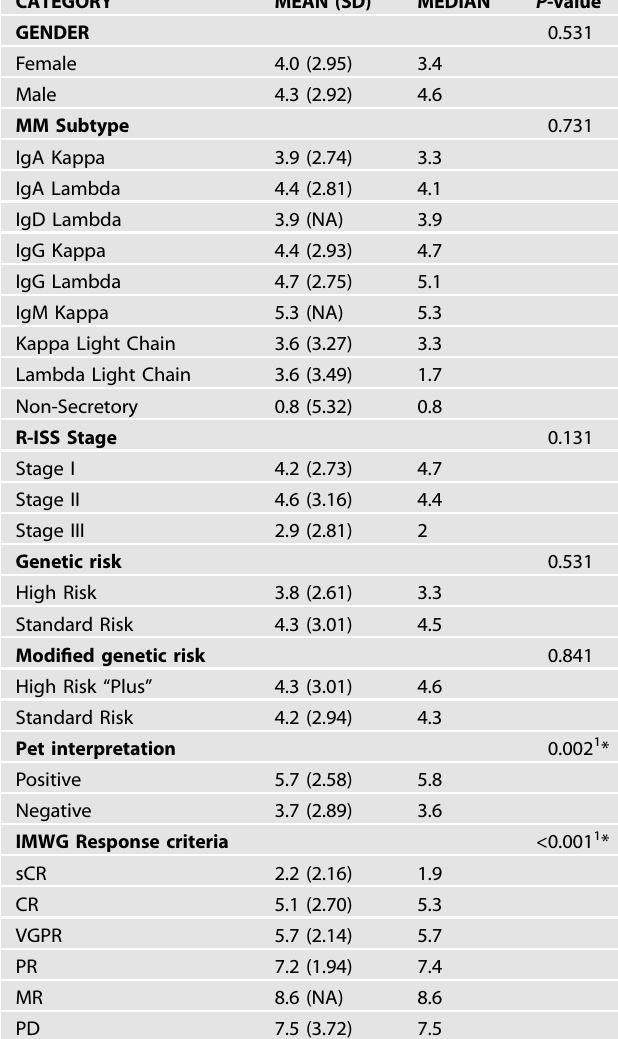
Table 4. Minimal Residual Disease (MRD) Positivity Value (Clone 1